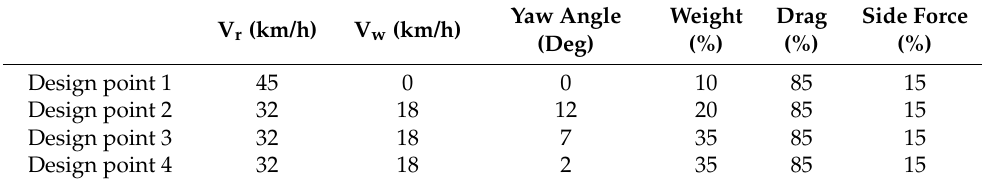
Table 1. The four design points and their